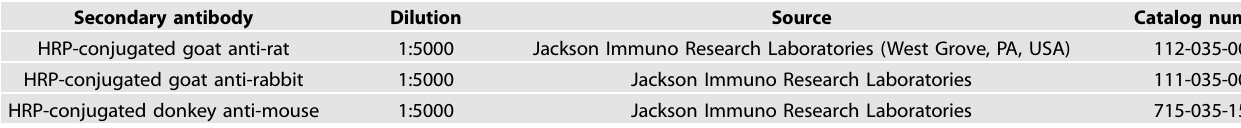
Table 4. Secondary antibodies used for western